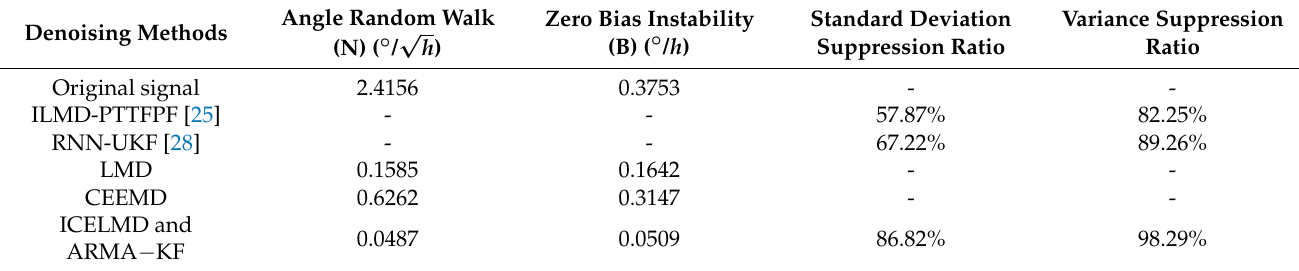
Table 3. Comparison of denoising